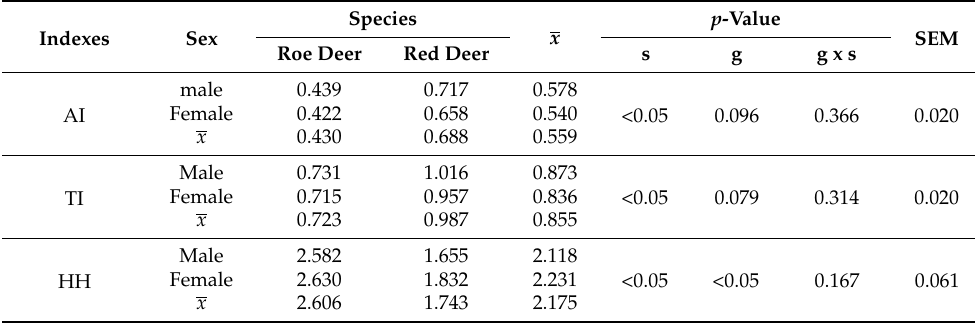
Table 6. Atherogenicity index (AI), thrombogenicity index (TI) and hypocholesterolaemic/ hypercholesterolaemic ratio (HH) of musculus